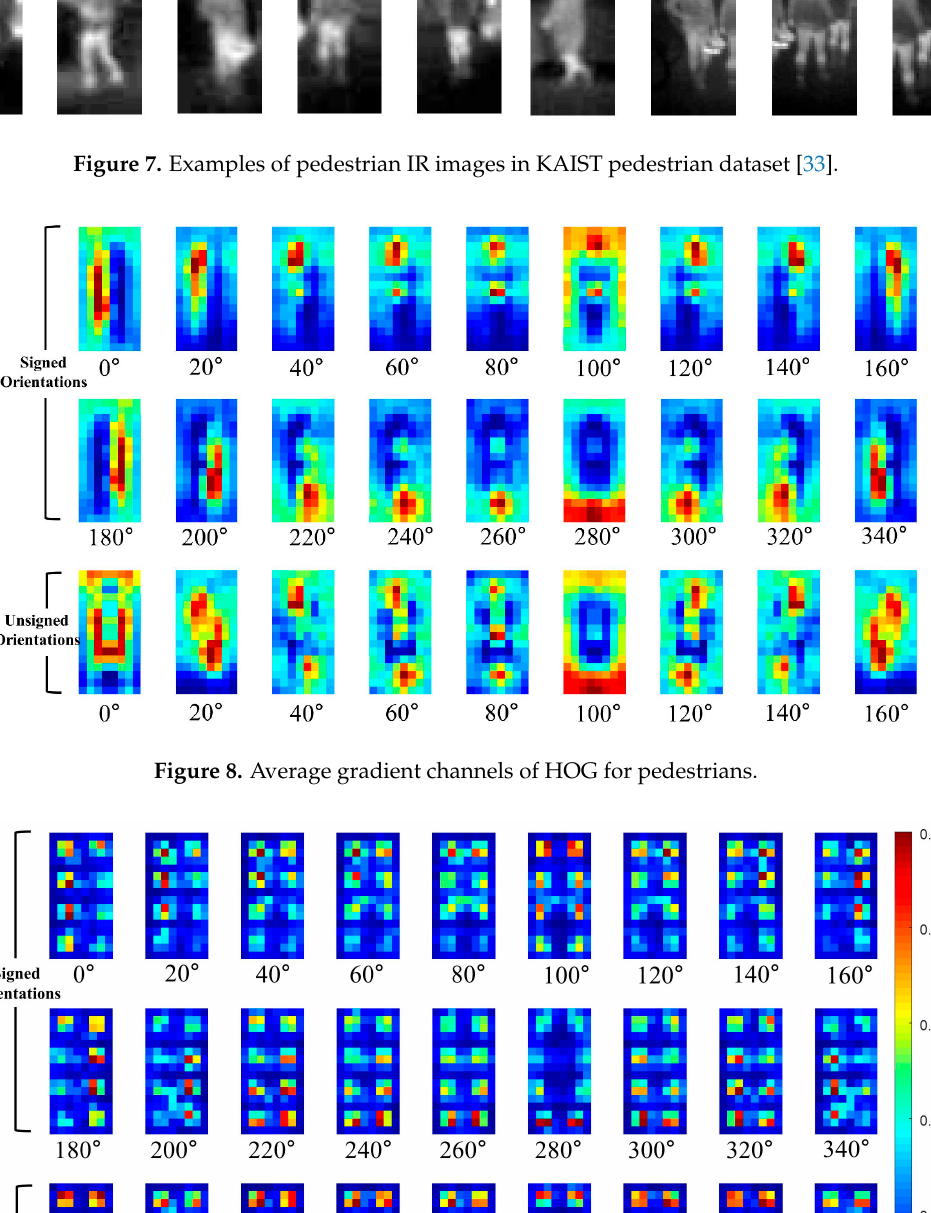
Figure 6. Example of P part extraction.